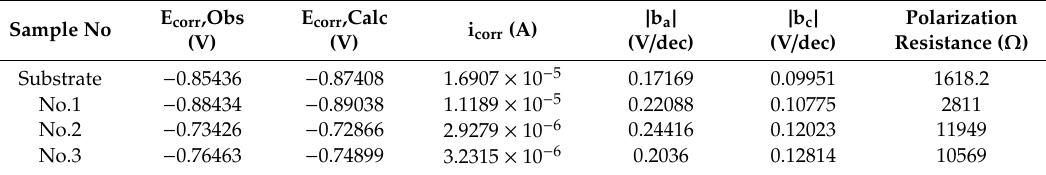
Table 5. The electrochemical parameters obtained from the polarization curves of the substrate and coatings.